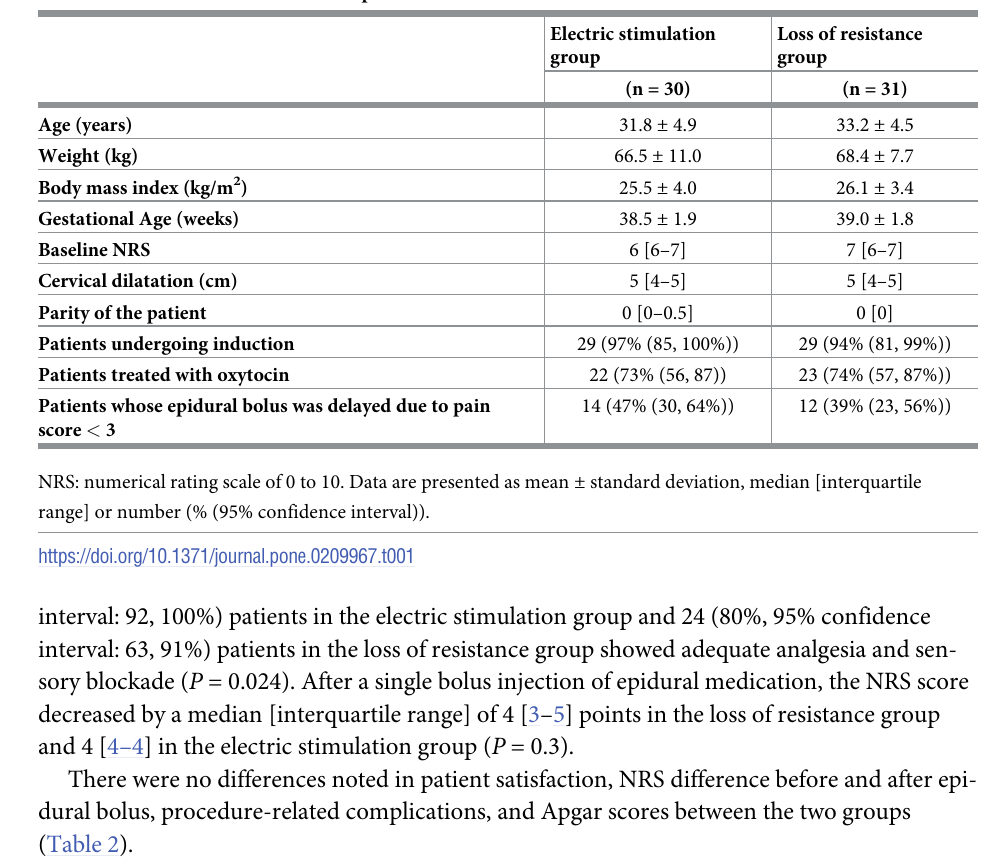
Table 1. Baseline characteristics of the patients.